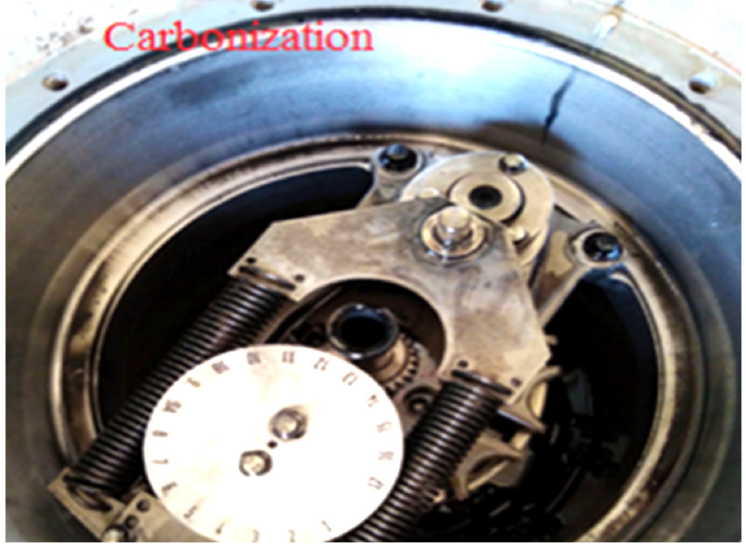
Figure 2 . Carbonized tap changer [5]. Figure 2. Carbonized tap changer [5].